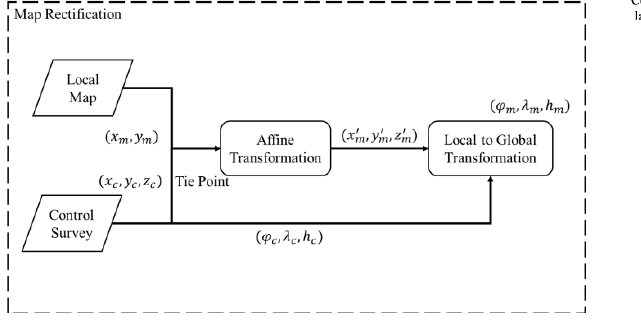
Figure 4. The flow chart of map rectification